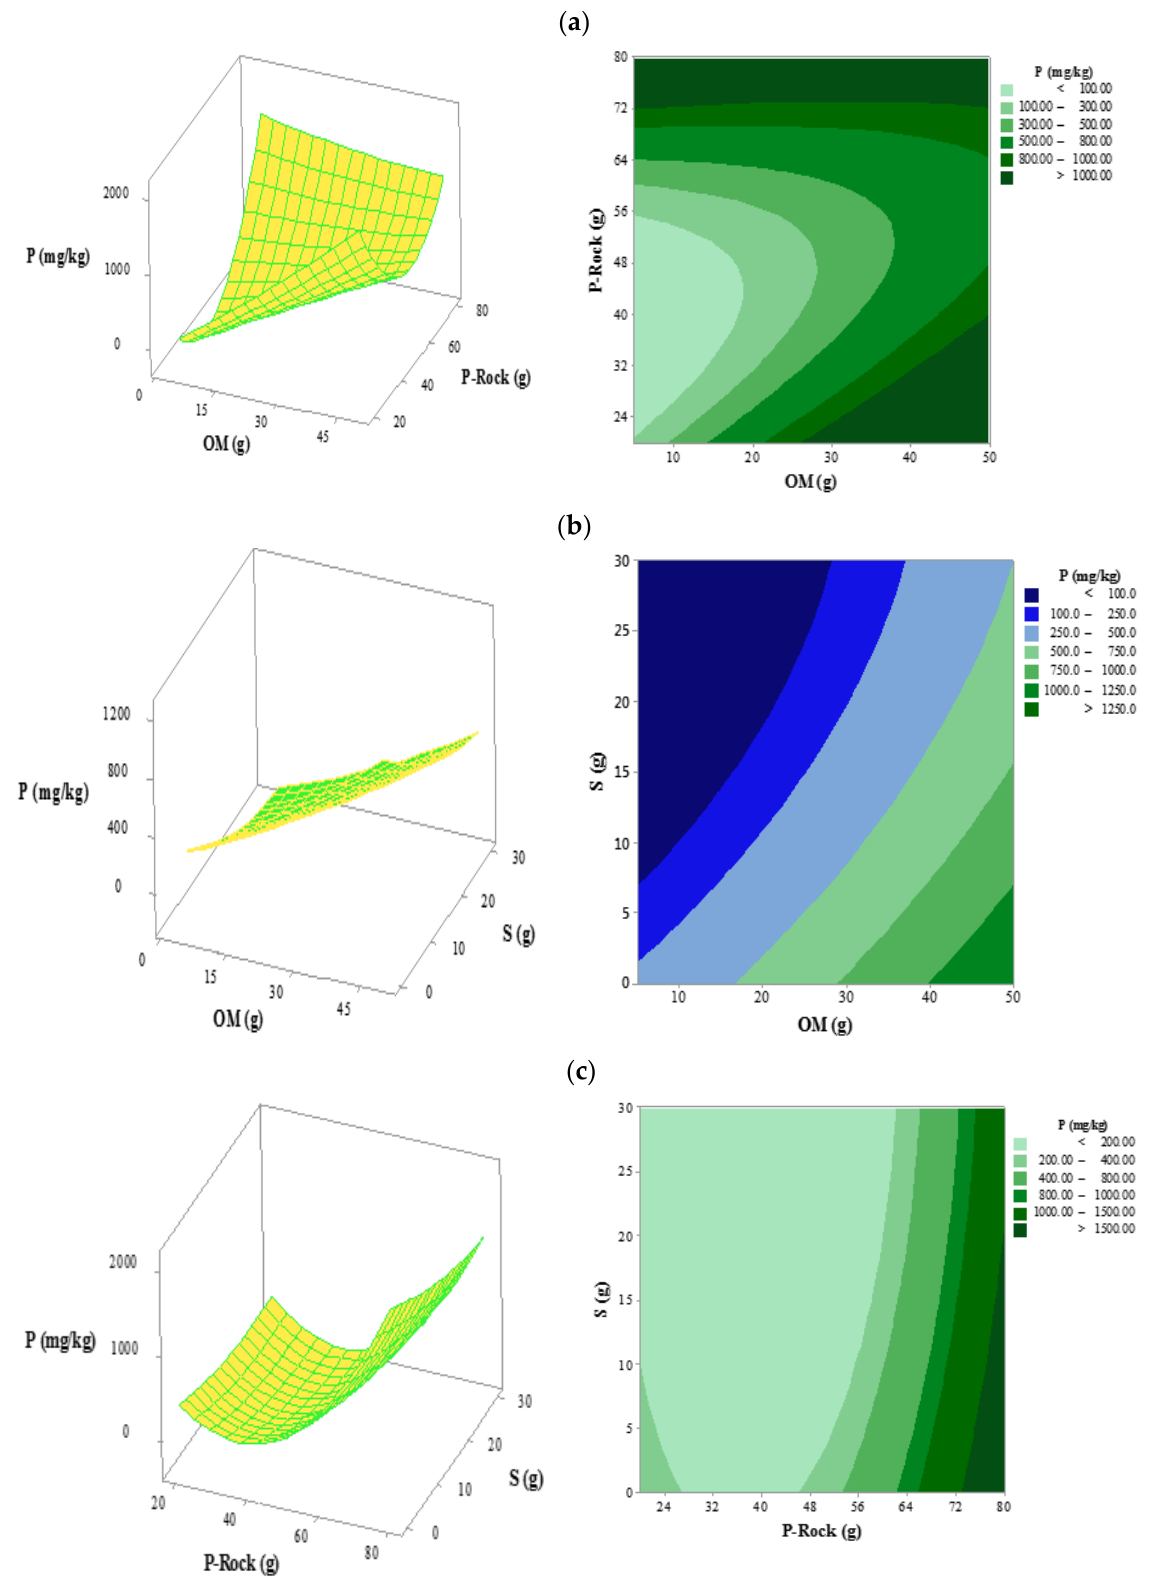
Figure 4. Three-dimensional (3D) and contour (2D) plots showing the interactive effects of ( a ) organic matter and phosphate rock levels, ( b ) organic matter and sulfur levels, and ( c ) phosphate rock and sulfur levels, on P solubilization. P ‐ Rock, phosphate rock; OM, organic matter; S, sulfur. Table 4. Optimized values of the model input parameters to obtain the maximum predicted dis ‐ solved P concentration.